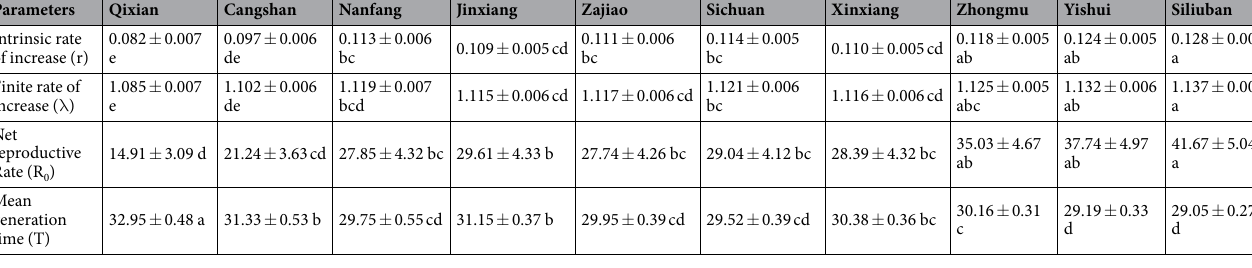
Table 2. The effects of 10 cultivars of garlic on Bradysia odoriphaga population parameters. The values (mean ± s.e.) and standard errors were calculated by using the bootstrap procedure with 10,000 bootstraps. The means followed by different letters in the same column are significantly different between cultivars at 5% significance level using the paired bootstrap test included in the computer program TWOSEX-MS Chart.